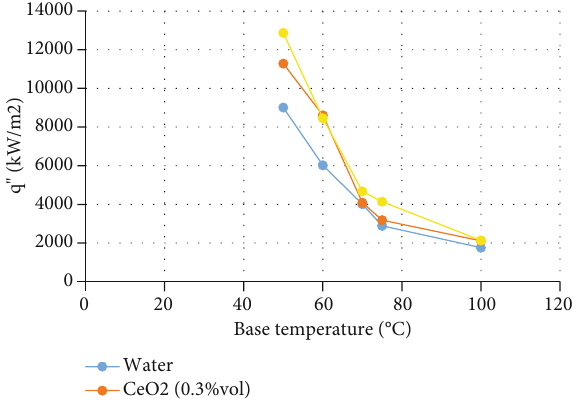
Figure 16: Heat fl ux variations based on base